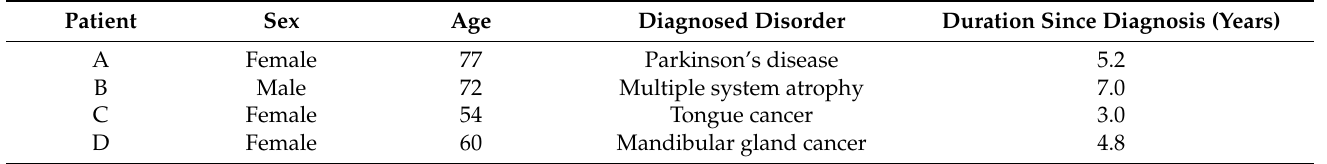
Table 1. Demographic information of